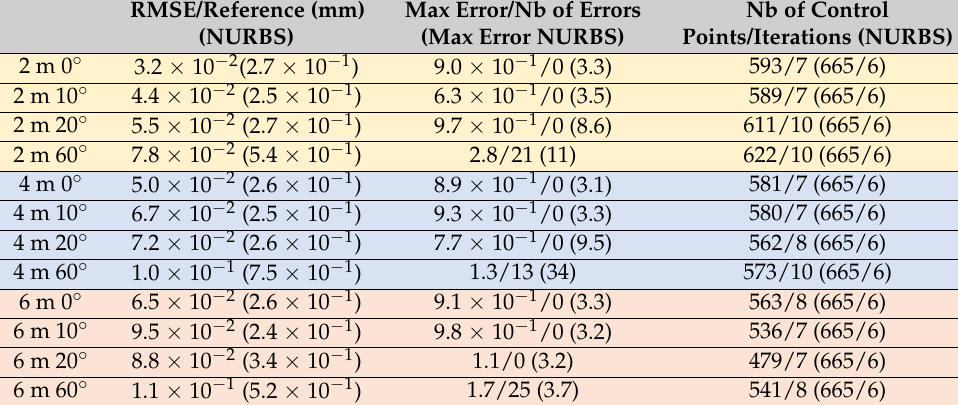
Table 2. Results of the approximation after calibration for different scanning configurations. The same criteria as in Table 1 are chosen to judge the goodness of fit. In brackets are the values obtained from the NURBS